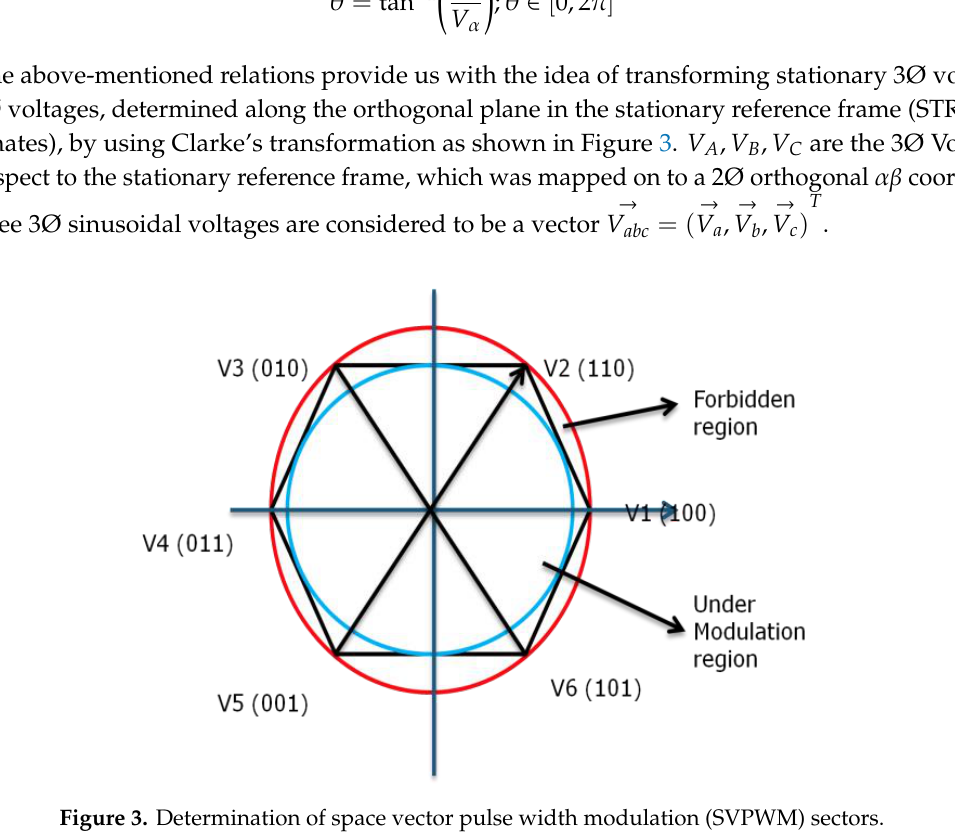
Figure 3. Determination of space vector pulse width modulation (SVPWM) sectors.